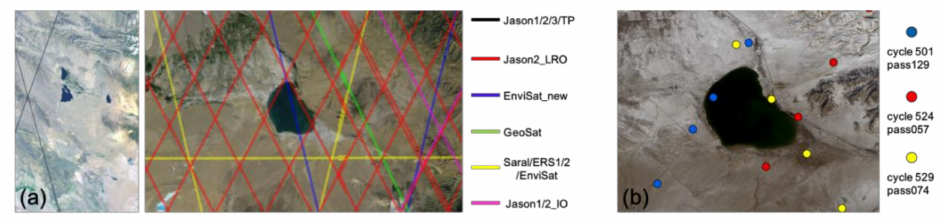
Figure 6. ( a ) Transit tracks of altimeter satellites (Jason 1/2/3/TP, Jason2_LRO, EnviSat_new, GeoSat, Saral/ERS1/2/EnviSat, and Jason 1/2_IO) over the Gahai Lake area. ( b ) The elevation points of Gahai Lake collected by the Jason2_LRO